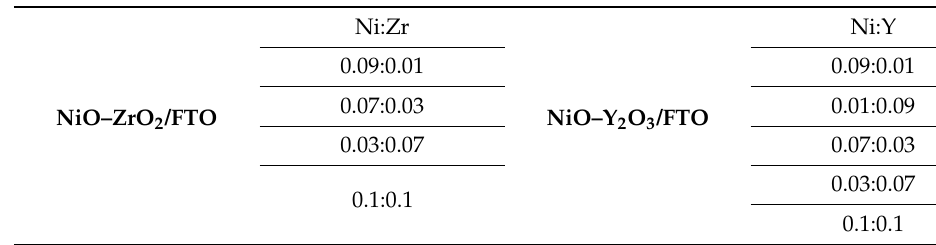
Table 1. Thin films fabricated with different ratios of precursors.